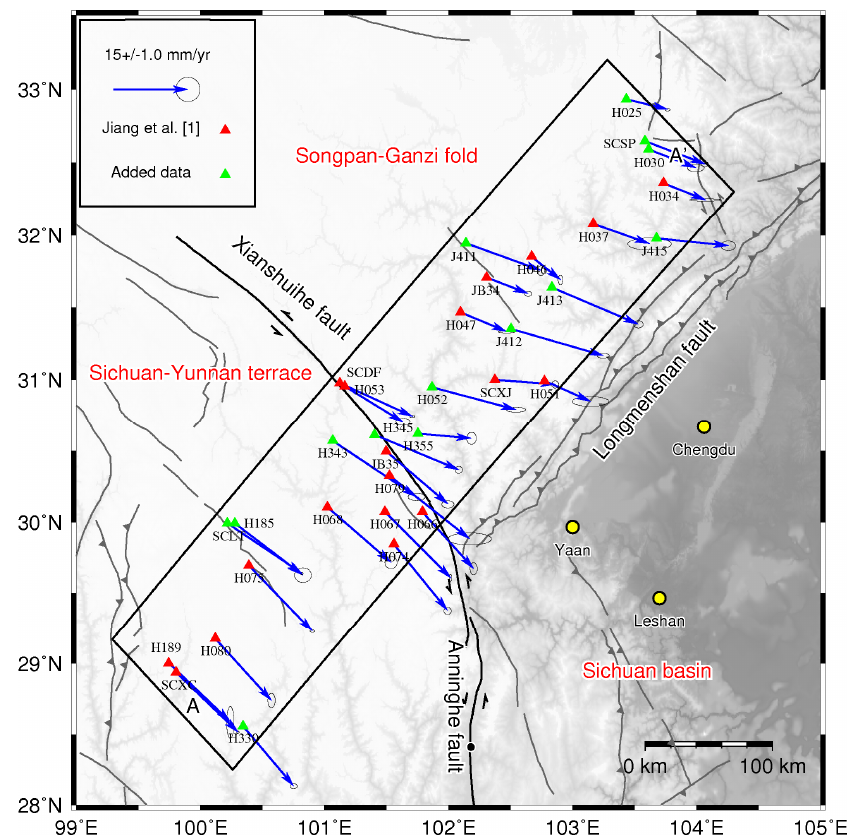
Figure 2. Distribution of global positioning system (GPS) stations across the SDK. Red and green triangles represent the stations used by Jiang et al. [1] and added stations, respectively. Blue arrows with error ellipses of 95% confidence represent interseismic GPS velocities relative to the stable Eurasian plate. A–A’ represents our studied region.